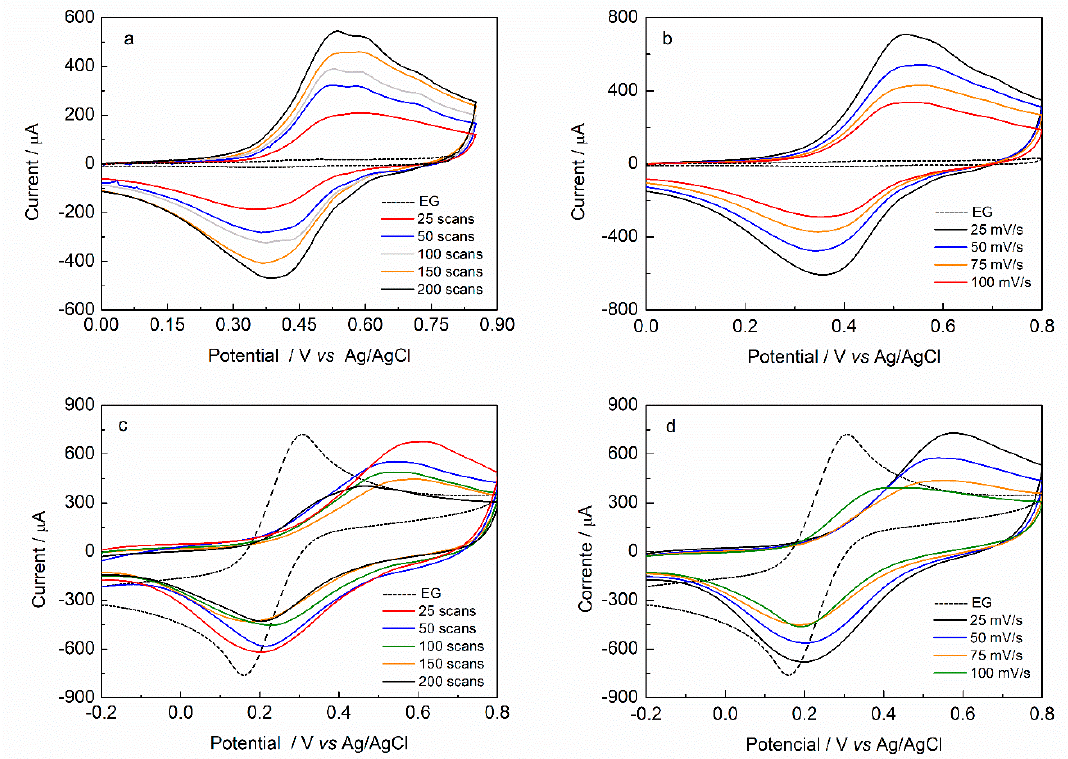
Figure 3. Cyclic voltammograms recorded in 0.5 M perchloric acid, 50 mV/s ( a , b ) and in 5.0 mM K 4 [Fe(CN) 6 ]/K 3 [Fe(CN) 6 ] containing 0.10 M KCl, 100 mV/s ( c , d ). Electrodes modified at ( a – c ) different number of scans (25, 50, 75, 100, 150, and 200) at a fixed scan rate of 50 mV/s and; and ( b – d ) different scan rates (25, 50, 75, and 100 mV/s) at a fixed number of scans of 100. (----) Cyclic voltammogram for GE.